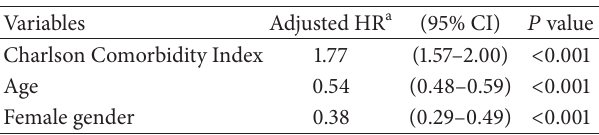
Table 3: Cox regression model: significant predictors of substance related disorder after